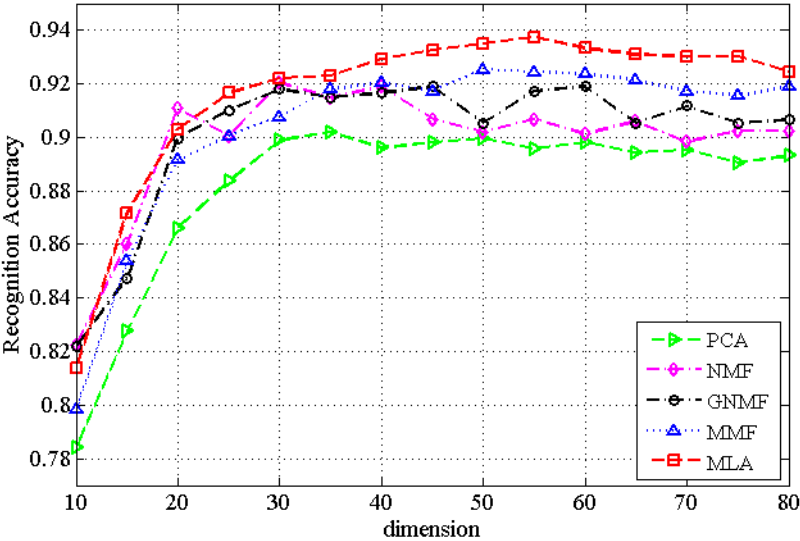
Figure 3. The recognition rates of different feature representation models across the range of the dimension of feature